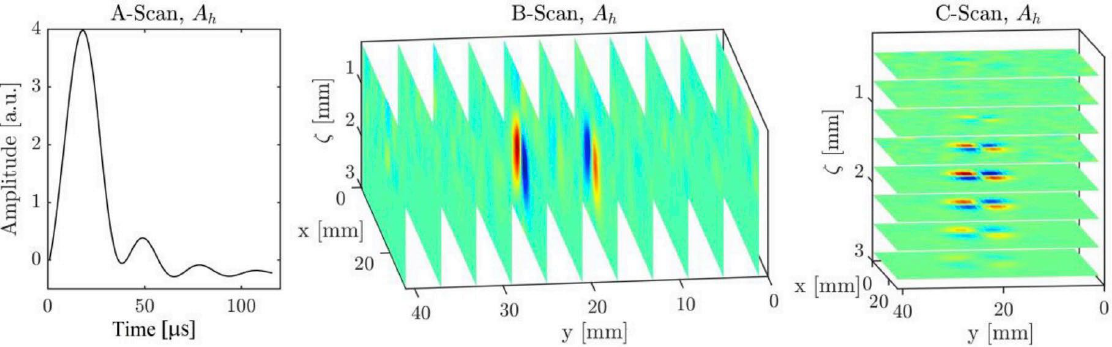
Figure 20. Various scanning modes where A-Scan is the pulse response of a single point; x , y , and ζ indicate the width, length, and depth of a rectangular plate, respectively [154].